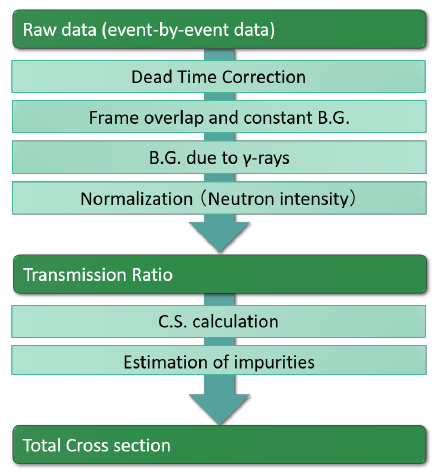
Figure 9. Flow chart of the data analysis procedure for total cross-section measurements in ANNRI.